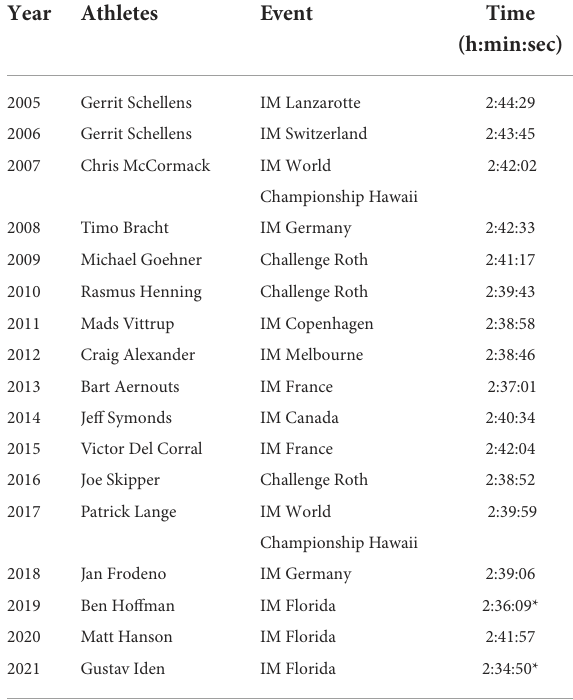
TABLE 7 Modulation of the cycling time and power output based on different drag coefficient scenarios and on different power reductions from drafting.